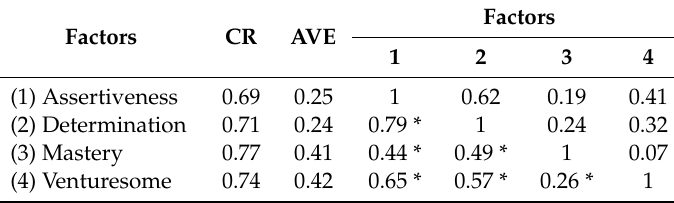
Table 4. Composite reliability (CR), average variance extracted (AVE), and squared